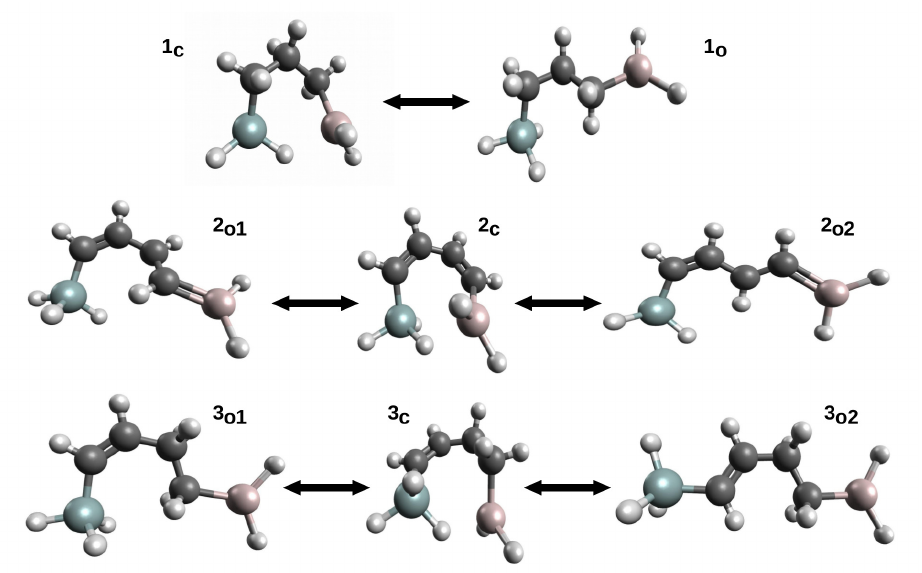
Figure 6. Closed and some open forms of ( 1 ) H 3 Si-CH 2 -CH 2 -CH 2 -AlH 2 , ( 2 ) H 3 Si-CH=CH-CH= CH-AlH 2 and ( 3 ) H 3 Si-CH=CH-CH 2 -CH 2 -AlH 2